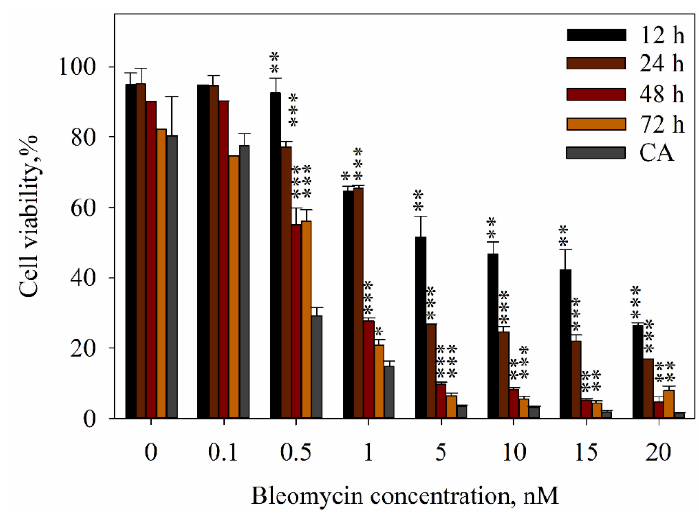
Figure 4. Dependence of cell viability after treatment with different bleomycin concentrations following electric pulses in the presence of plasmid DNA as assessed by a flow cytometry assay (FCA) at various time points after the treatment (12, 24, 48, 72 h) and a clonogenic assay (CA) (six days after treatment). The cells were electroporated with one high-voltage (1400 V/cm, 100 µs) electric pulse. A two-tailed Student’s t-test value p < 0.05 between the cell viability evaluated by a clonogenic assay and cell viability at different time points after electroporation is marked with *, p < 0.01 is marked with with **, and p < 0.001 is marked with ***.